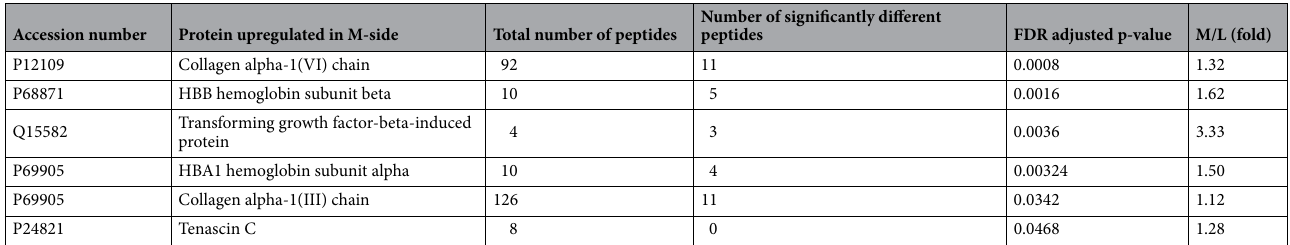
Table 2. Results of label-free MS of hemoglobin subunits alpha and beta with a significant overexpression in the contracted M-side, in comparison with the non-contracted L-side of the relapsed clubfoot tissue. The total number of peptides indicates the number of successfully compared tryptic peptides detected in at least 50% of all samples. Specific accession numbers of proteins are used from the UNIPROT database (www. unipr ot. org) and M/L (fold change) symbolizes the ratio of the protein concentration